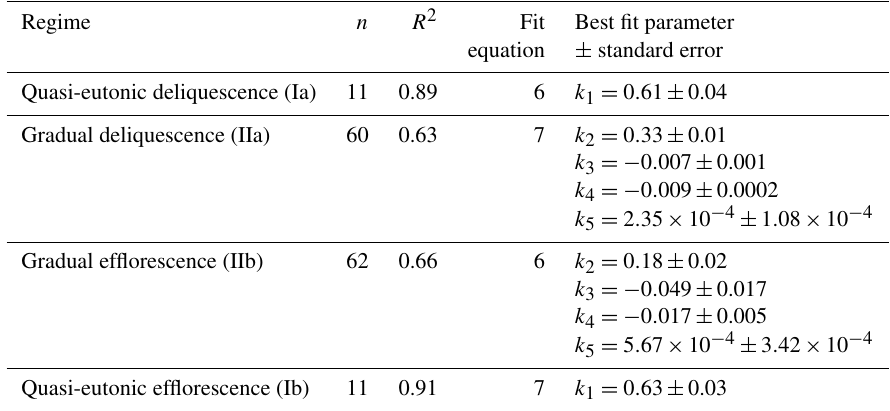
Table 1. KIM fit parameters for the SPB sample with dry particle mass of 3.5fg ( D b = 160nm). The columns n and R 2 give the number of data points and the coefficient of determination of the